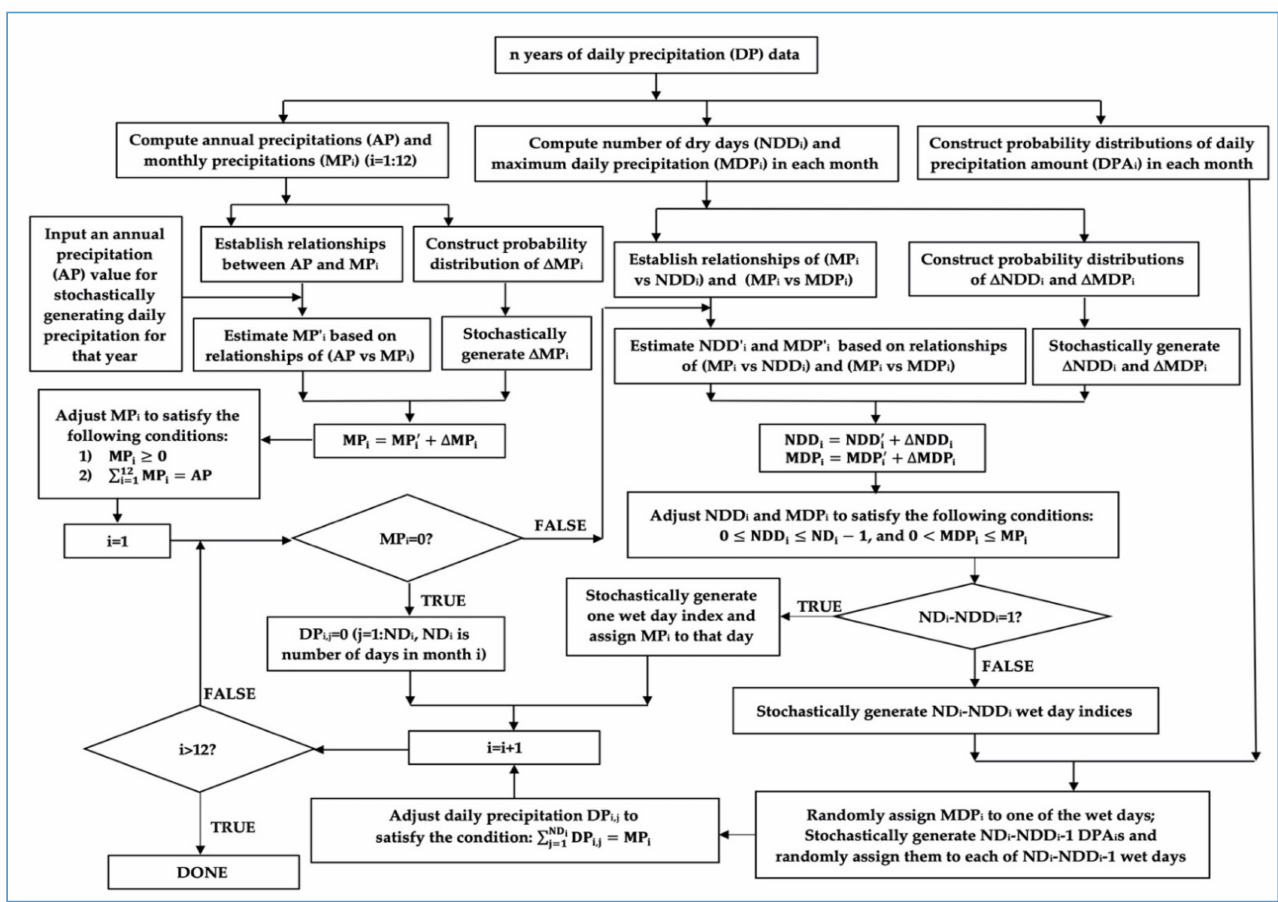
Figure 2. Flowchart of the daily precipitation generation in the